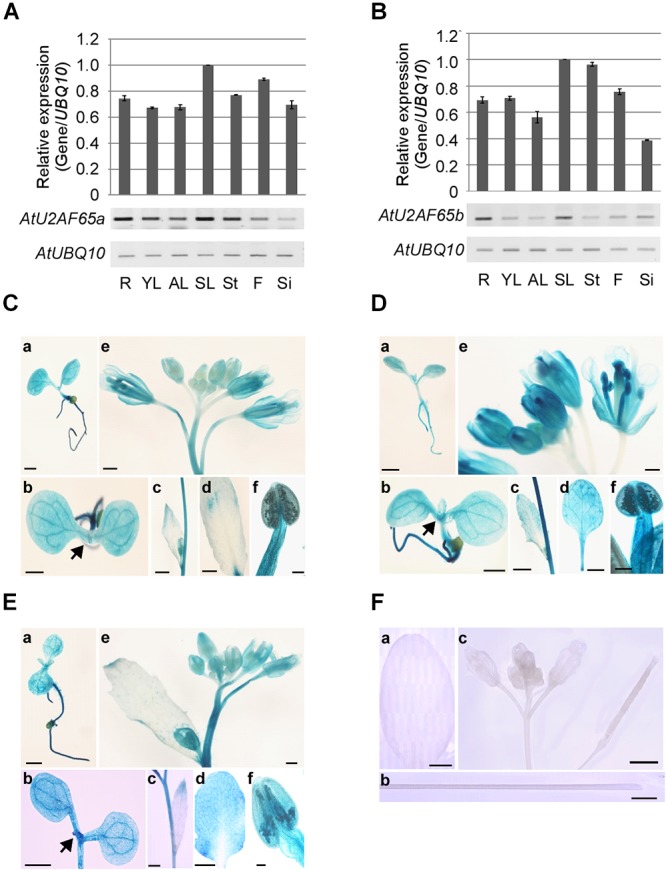
Expression patterns of AtU2AF65a and AtU2AF65b genes. (A,B) RT-PCR analysis of AtU2AF65a and AtU2AF65b expression in a variety of tissues [roots (R), young leaves (YL), adult leaves (AL), senescent leaves (SL), stems (St), flowers (F), and siliques (Si)] of wild-type (Col-0) plants grown at 23°C under LD conditions. The expression level of each AtU2AF65 gene in SL was set to 1. AtUBQ10 expression served as a loading control. The error bars indicate the SEM of three biological replicates consisting of independently harvested samples, with technical replicates for each sample. (C–F) Histochemical GUS staining in pAtU2AF35a0.9
kb::GUS
(C), pAtU2AF35b0.7
kb::GUS
(D), pAtU2AF65a1.3
kb::GUS
(E), and GUS
(F) plants under LD conditions. GUS staining was performed in a variety of tissues [seedlings (a,b), cauline leaves (c), adult leaves (d), inflorescences (e), and stigmas (f)]. Arrows indicate shoot apex regions. GUS expression was not detected in transgenic plants harboring GUS constructs without a promoter region [F, adult leaves (a), stems (b), and inflorescences (c)]. Scale bars 100 μm. Note that the GUS expression patterns of pAtU2AF35b0.7
kb::GUS were similar to those of pAtU2AF35b550
bp::GUS or pAtU2AF35b982
bp::GUS, as previously described (Wang and Brendel, 2006).